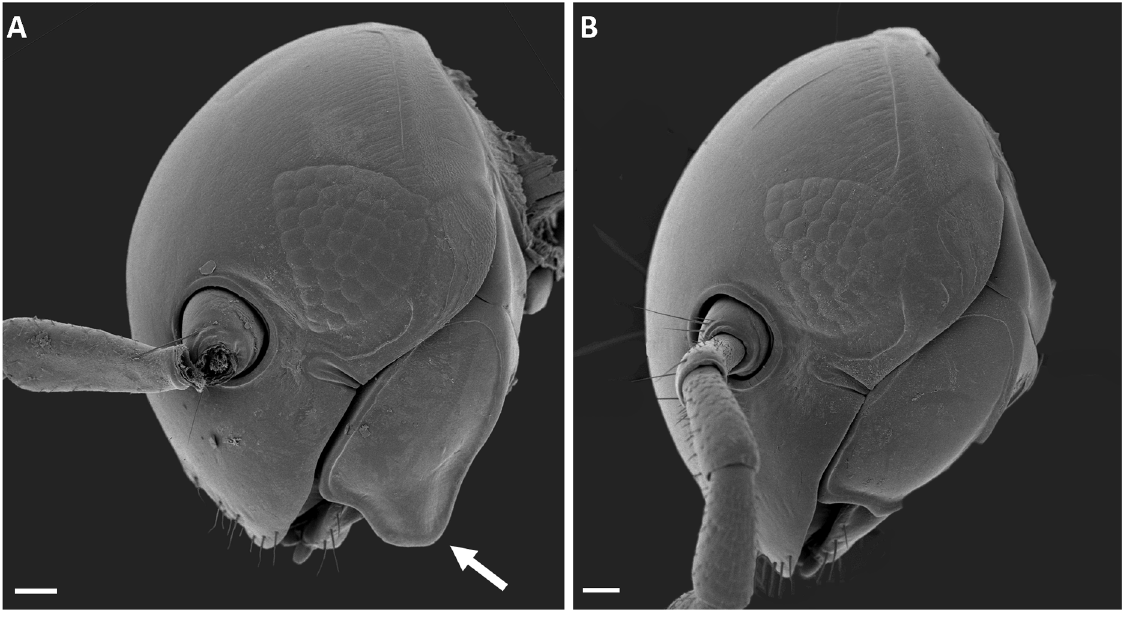
Fig. 2. Aquattuor udzungwensis Enghoff, 2015, specimens from Chita, heads, lateral view. A . Male (NHMD 621667). B . Female (NHMD 621667). Scale bars = 0.1 mm. The arrow points at the disto- ventral stipital expansion lobe in the